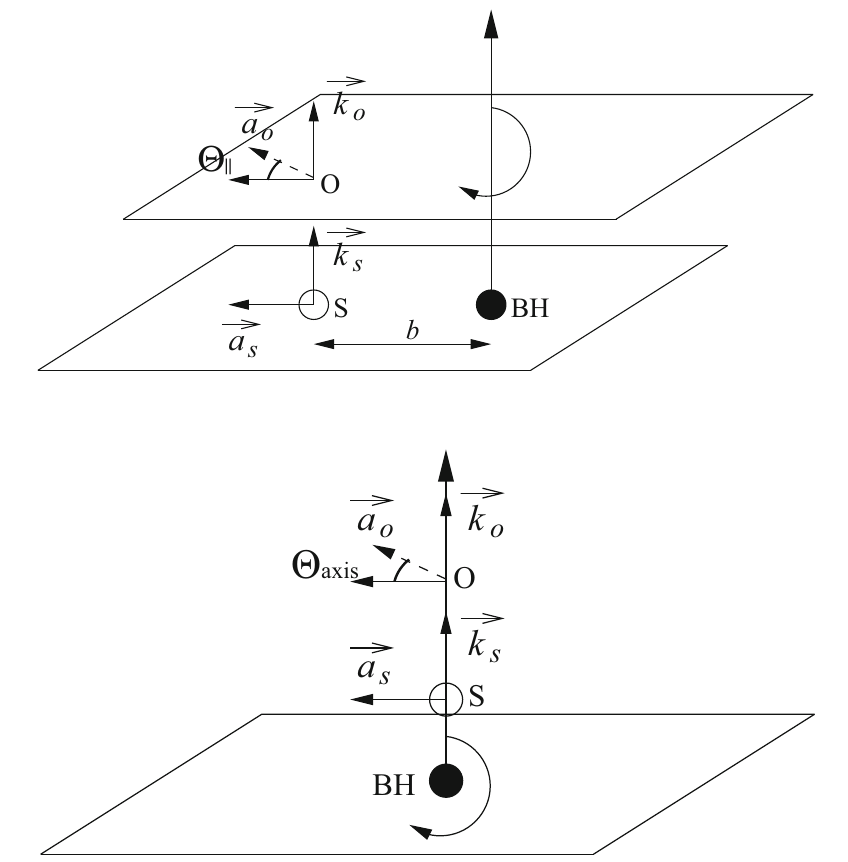
Fig. 1 At top, the source and the observer are at distance b from the symmetry axis. At bottom, both source and observer are in the symmetry axis. The vector tangent to the null congruence and polarization vector are indicated by The black hole, the source, and the observer are indicated by BH, S, and O,